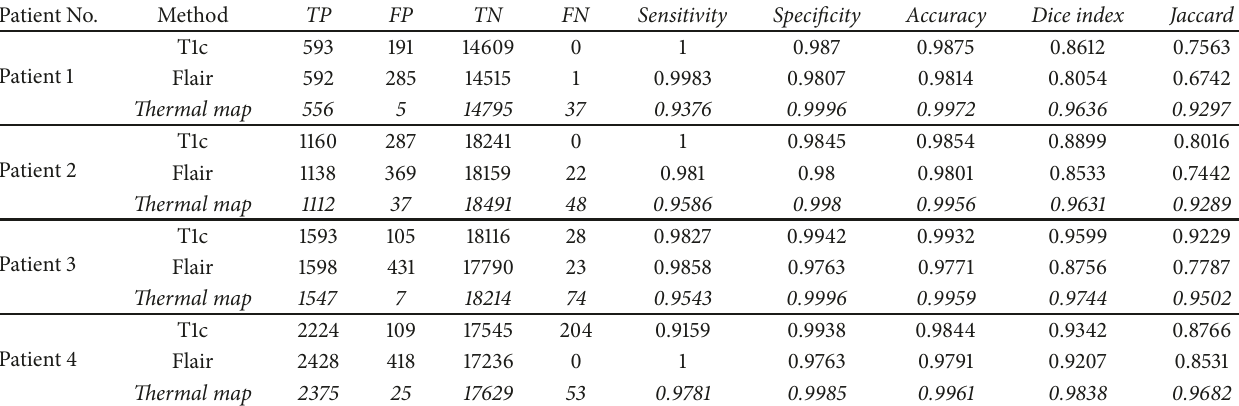
Table 2: The calculated segmentation evaluation metrics for level set method and proposed approach. Patient No.